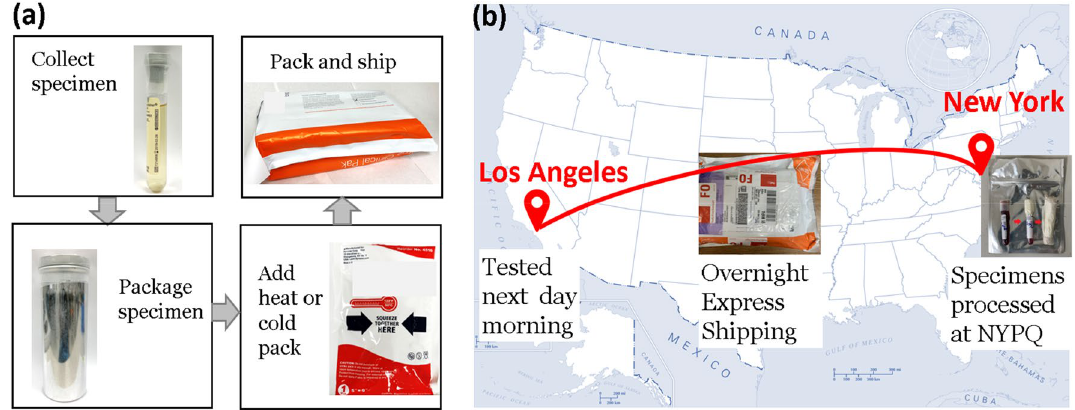
Figure 1. ( a ) Patient-side specimen collection and transportation package, ( b ) specimens shipped from NYPQ via FedEx Clinical Pak. Map was generated by a search on Wikimedia with "no-restriction" license rights (https:// commo ns. wikim edia. org/ wiki/ File: US_ state_ outli ne_ map. png). We then recolored it in Microsoft PowerPoint and added the locations of Los Angeles and New